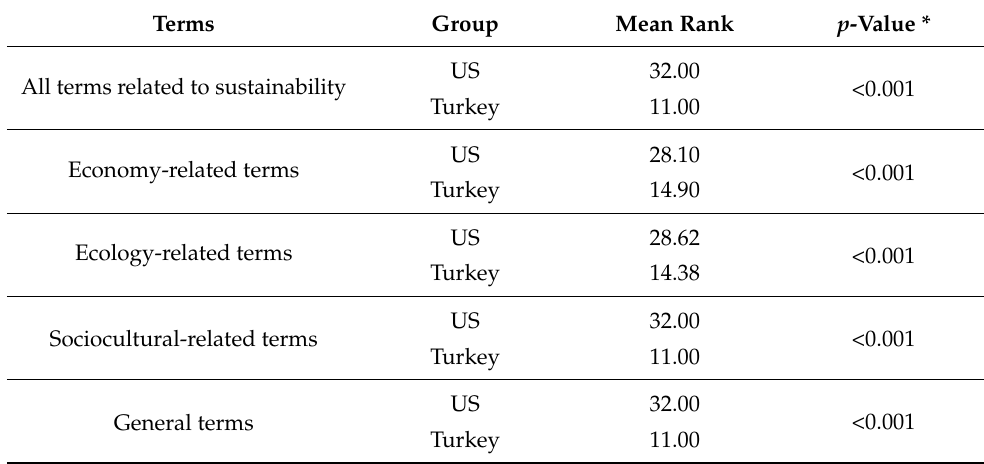
Table 3. Mann–Whitney U test results for uncategorized data and sustainability